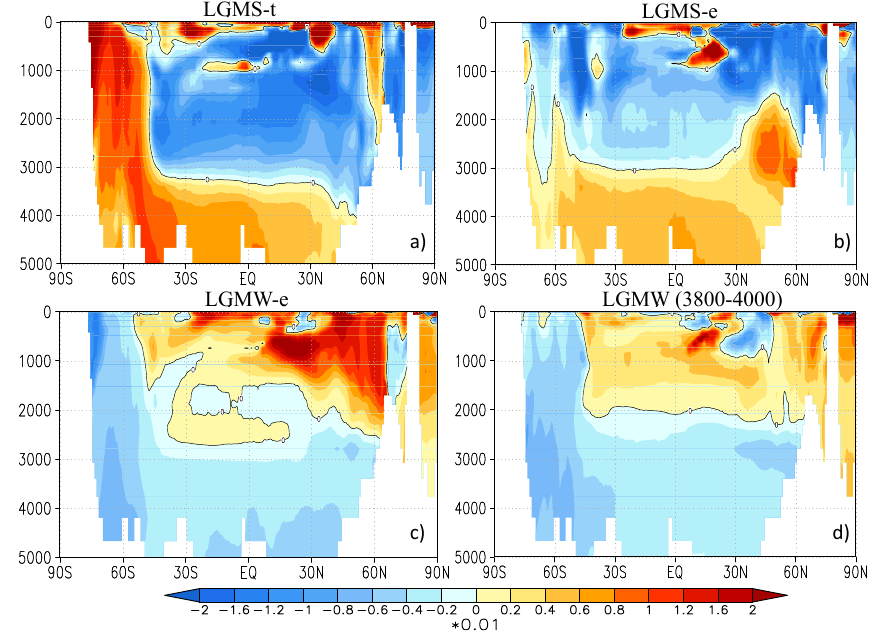
Fig. 4. Salinity trend in Atlantic Ocean for model year 2800–3000 in LGMS-t deep (A) and LGMW-e (C) and model year 4500–4700 in Figure 4 Salinity trend in Atlantic Ocean for model year 2800-3000 in LGMS-e (B) and model year 3800–4000 in LGMW (D) . Units: psucentury − 1 . LGMS-t (A) and LGMW-e (C) and model year 4500-4700 in LGMS-e deep (B) and model year 3800-4000 in LGMW (D). Units: psu/century. our model as well as PMIP2 models underestimate the pro- nounced east–west SST anomaly gradient in the northern North